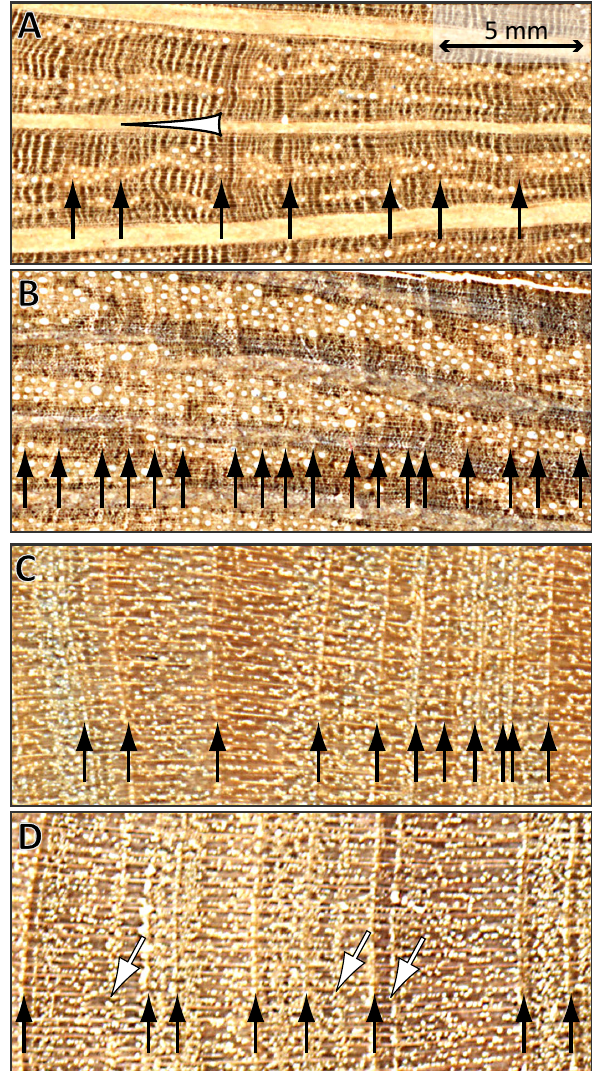
Fig. 3. Example wood sections of (A, B) : Q.ilex and (C, D) : A.unedo with true (black arrows) and false (white arrows) rings marked. The white marking in (A) indicates the decreasing vessel size within one year. All sections have the same